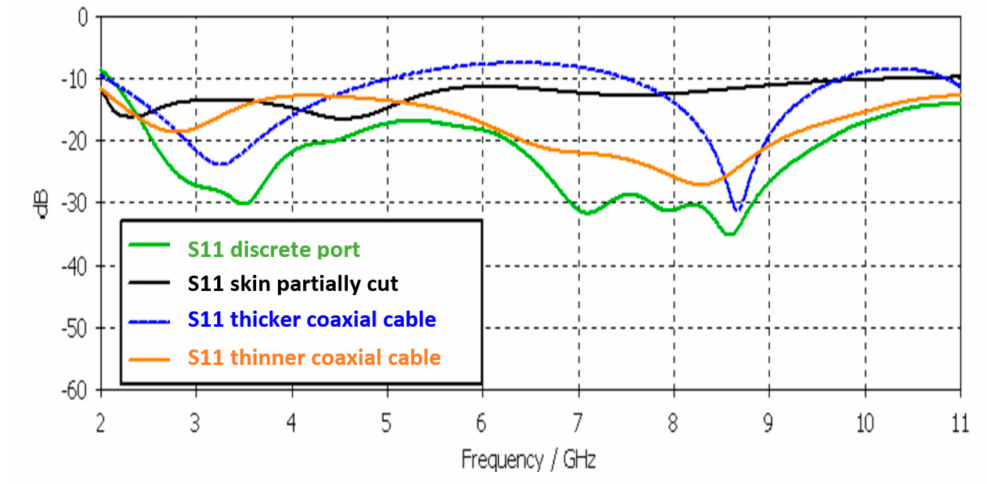
Figure 6. S11 results simulated with the layer model with different antenna-skin distances (coaxial cable